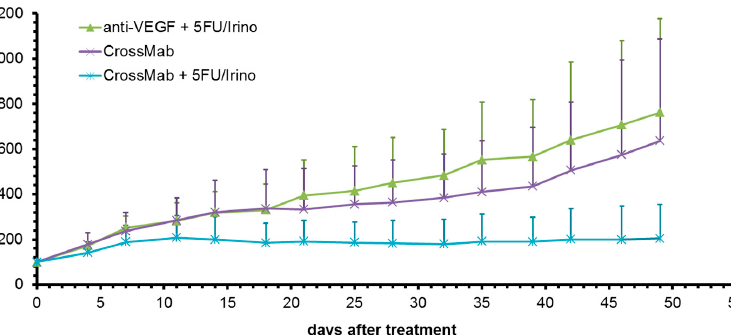
Figure 2. Analysis of tumor growth inhibition comparing CrossMab mediated co-targeting Vascular endothelial growth factor (VEGF) and Ang-2 vs. clinical standard anti-VEGF treatment in combination with chemotherapy. Mice were treated once weekly starting on day 0. ( A ) All groups. Values are means of tumor volumes ± standard deviation ( n = 10). ( B ) Three most responsive groups. Shown are mean tumor volumes normalized to day 0 as percent ± standard deviation ( n = 10).